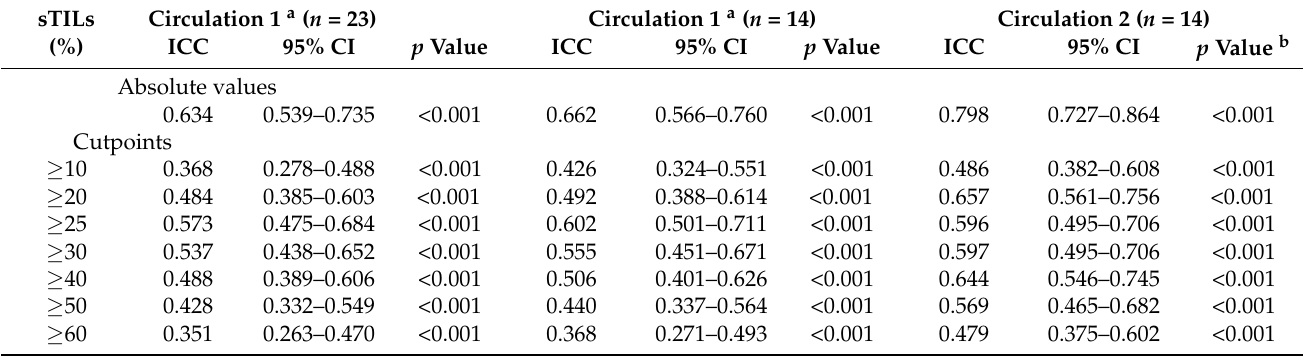
Table 1. Inter-observer agreement between pathologists scoring sTILs in circulation 1 and